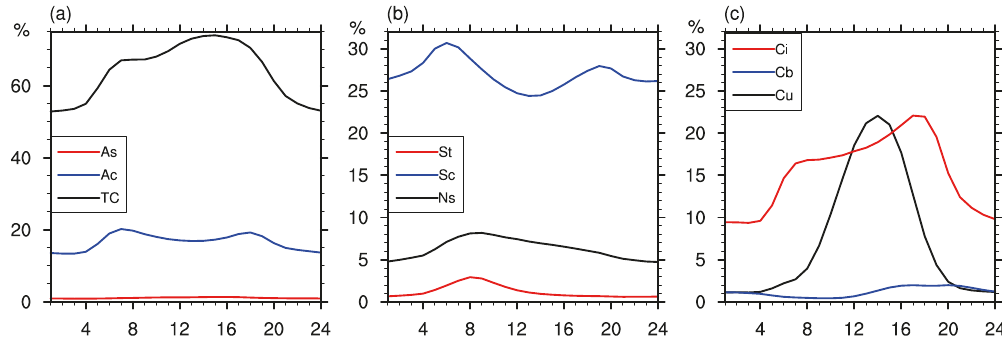
Figure 1. The diurnal variation of the occurrence frequencies (%) of various cloud types in central and east China during 1981–2011: ( a ) TC, Ac, As, ( b ) Ns, Sc, St, ( c ) Cu, Cb, Ci(the horizontal axis represents the local solar time, and the vertical axis represents the occurrence frequency of